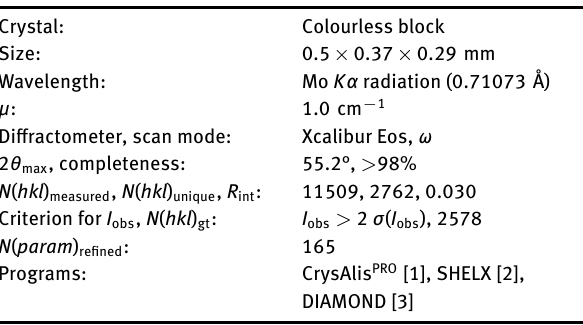
Table 2 lists the atoms with their coordinates and displace- ment